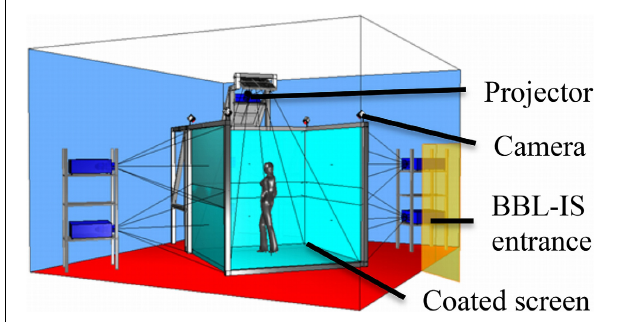
FIGURE 3 | Schematic representation of the “BBL-IS”